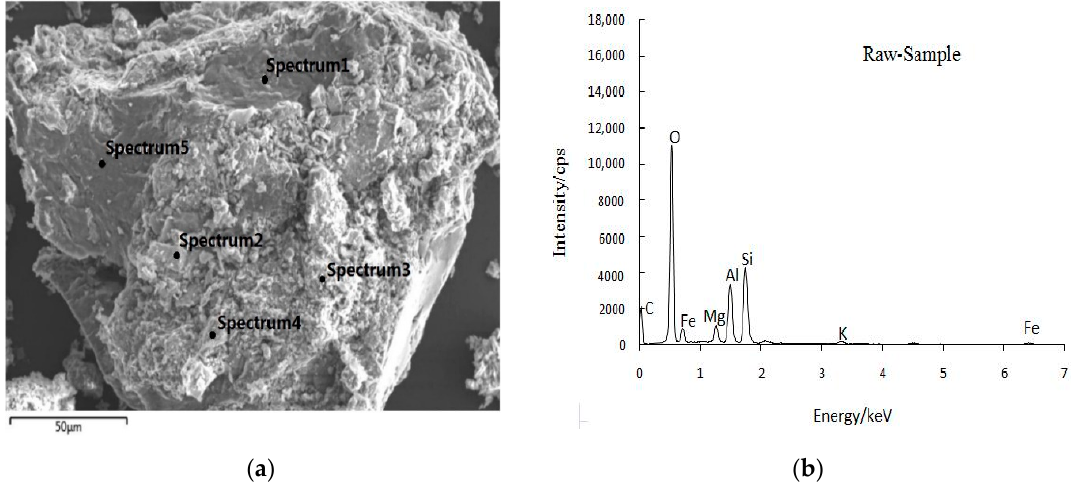
Figure 5. SEM and EDS spectrum of Raw-CG. ( a ) SEM Spectrum of Raw-CG; ( b ) EDS Spectrum of Raw-CG. Spots Spectrum: scanning spots of Raw-CG.